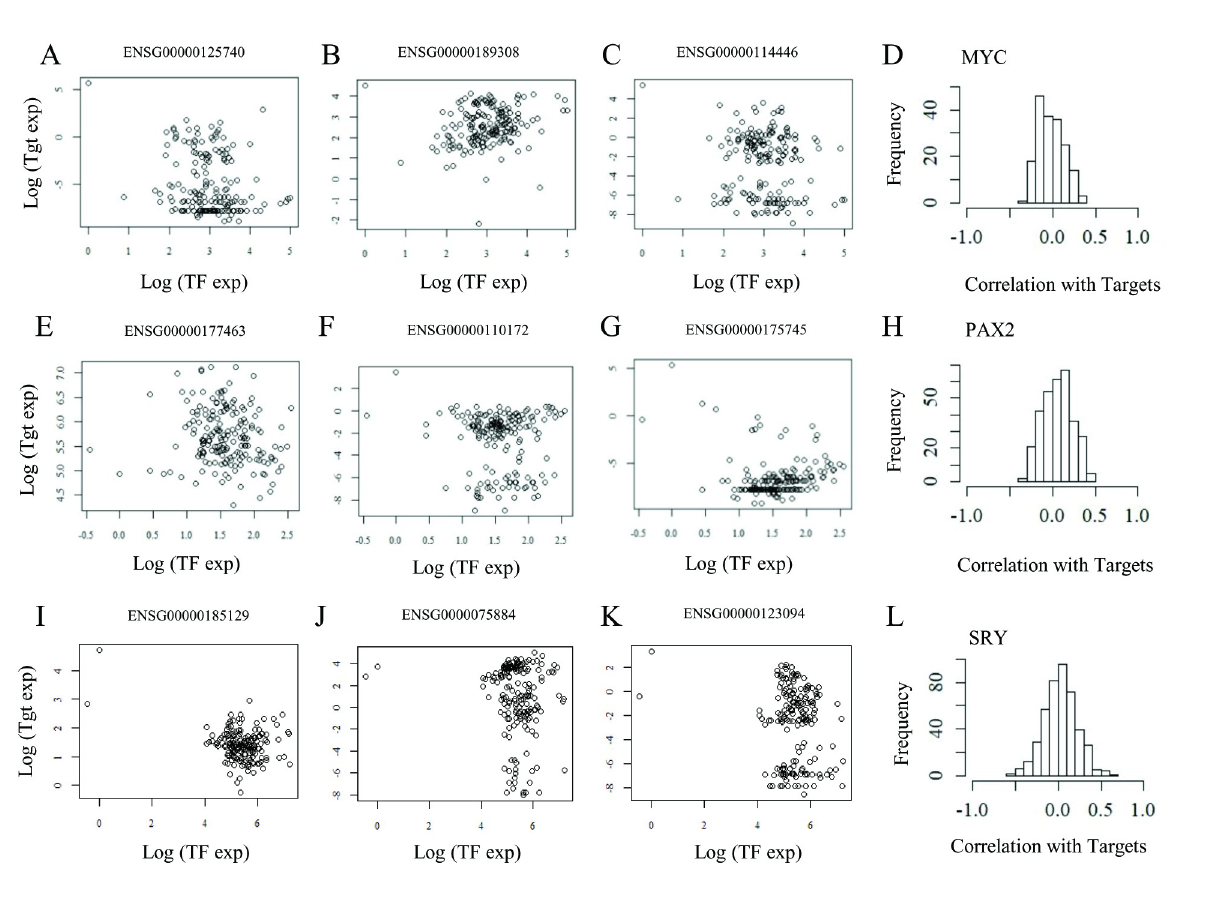
Fig 4. Transcriptional regulators in natural transcriptomes are poorly correlated with their individual targets. (A-C): Scatter graphs showing the level of expression of three out of 400 known targets (Tgt, expressed as log-transformed values) of the transcription factor MYC, as a function of the level of expression of this same transcription factor (TF). D) Distribution of correlations between MYC expression against 400 identified MYC targets. (E-G): Scatter graphs showing the level of expression of three independent targets of the transcription factor PAX2, as a function of the level of expression of this same transcription factor. H) Distribution of correlations between PAX2 expression against 400 identified targets. (I-K): Scatter graphs showing the level of expression of three independent targets of the transcription factor SRY, as a function of the level of expression of this same transcription factor. L) Distribution of correlations between SRY expression against 400 identified targets. Ensembl IDs for each individual target in the scatter graphs are indicated. For each transcription factor, the scatter graph shown correspond to percentiles 25, 50 and 75 of the correlation distribution for each set of